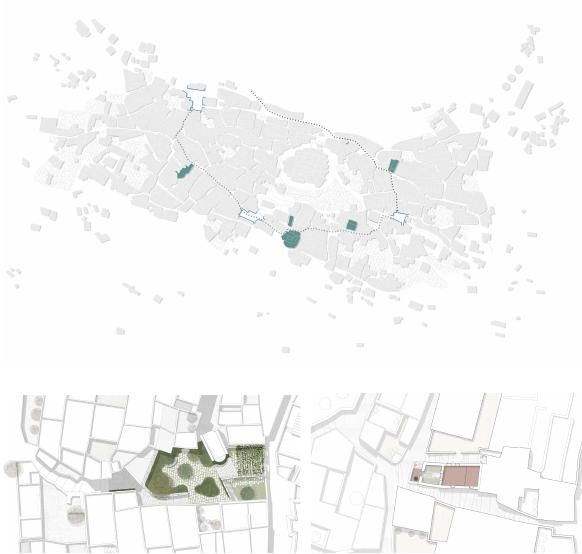
Figure 15. Masterplan whit the identified walk and the degraded areas; and zoom of two projects.